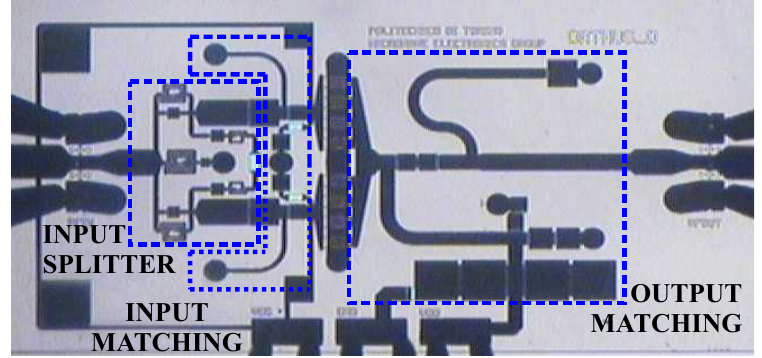
Figure 5. Microscope picture of the Doherty PA MMIC fabricated with the TriQuint foundry process, first generation. The building blocks are